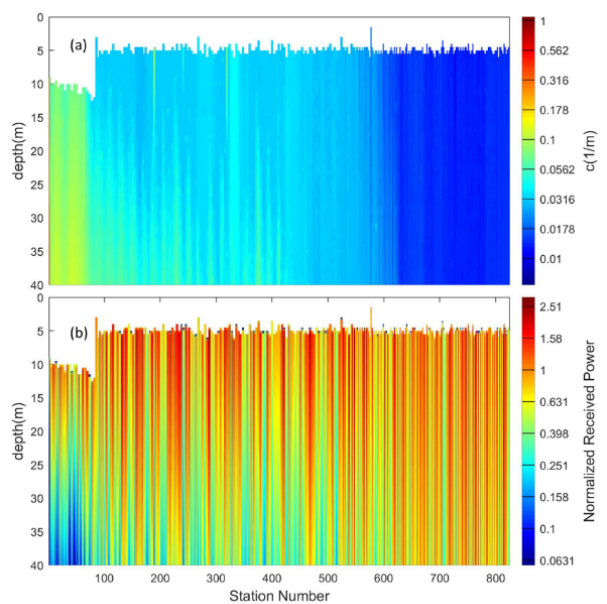
Figure 3. ( a ) Cross section of the observed volume attenuation coefficient c ( z ) along the tracks of NAVOCEANO Seaglider NG270 from January 6 to February 28, 2014 (red) without typhoon activity, and ( b ) the calculated normalized received power P n ( z ). The horizontal axis shows the glider’s location along the magenta-colored track in Figure 2a with Station-1 located at 19°36′32” N, 124°58′56” E at 05:01 UTC, January 9, 2014 and Station-825 at 19°59′27” N, 127°34′05” E at 17:26 UTC, February 28, 2014. Note that there was no typhoon passing by during that period.